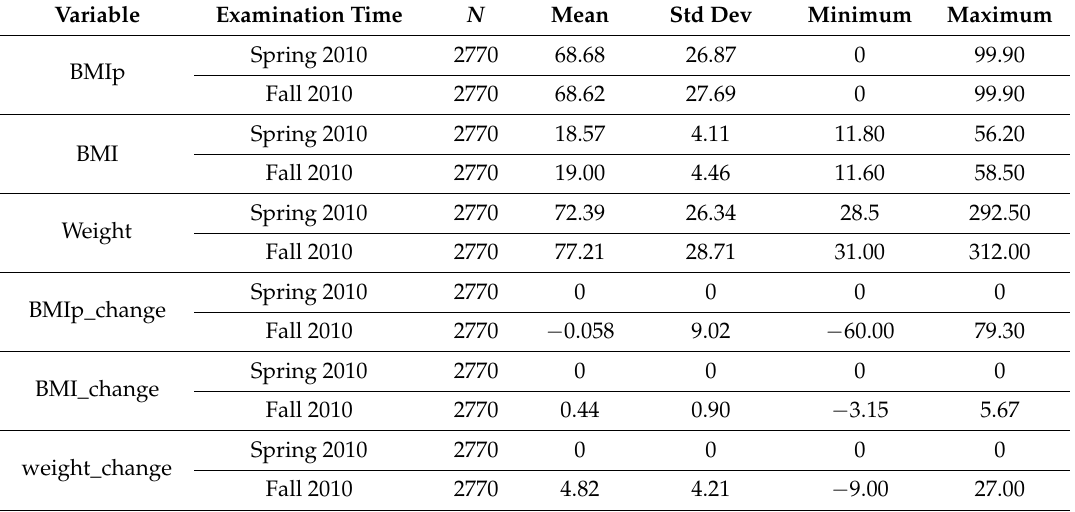
Table 2. Mean BMI percentile, BMI, and weight—Spring and Fall 2010 (including standard deviation (Std Dev), minimum and maximum values) (Total N =